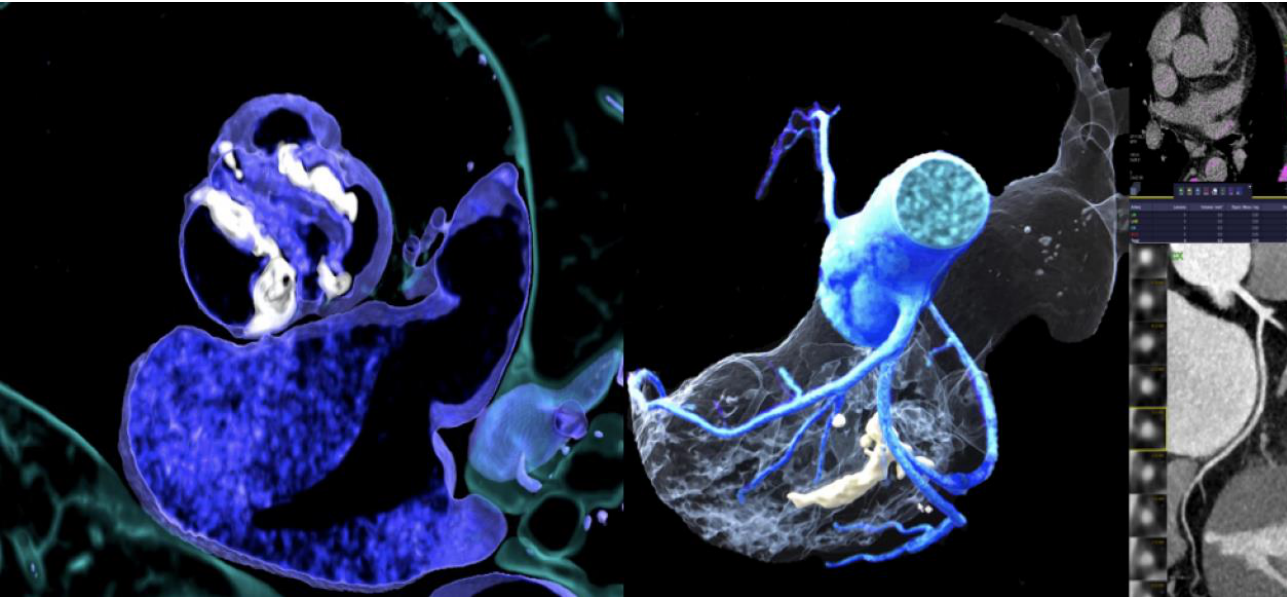
Figure 2. 72 years-old-male with severe bicuspid AS (Type I, Raphe L/R) (left), zero CACS (right, upper) and no coronary stenosis by CTA (right). Table 2. Coronary artery calcium score (CACS) and coronary artery disease profile by CTA.